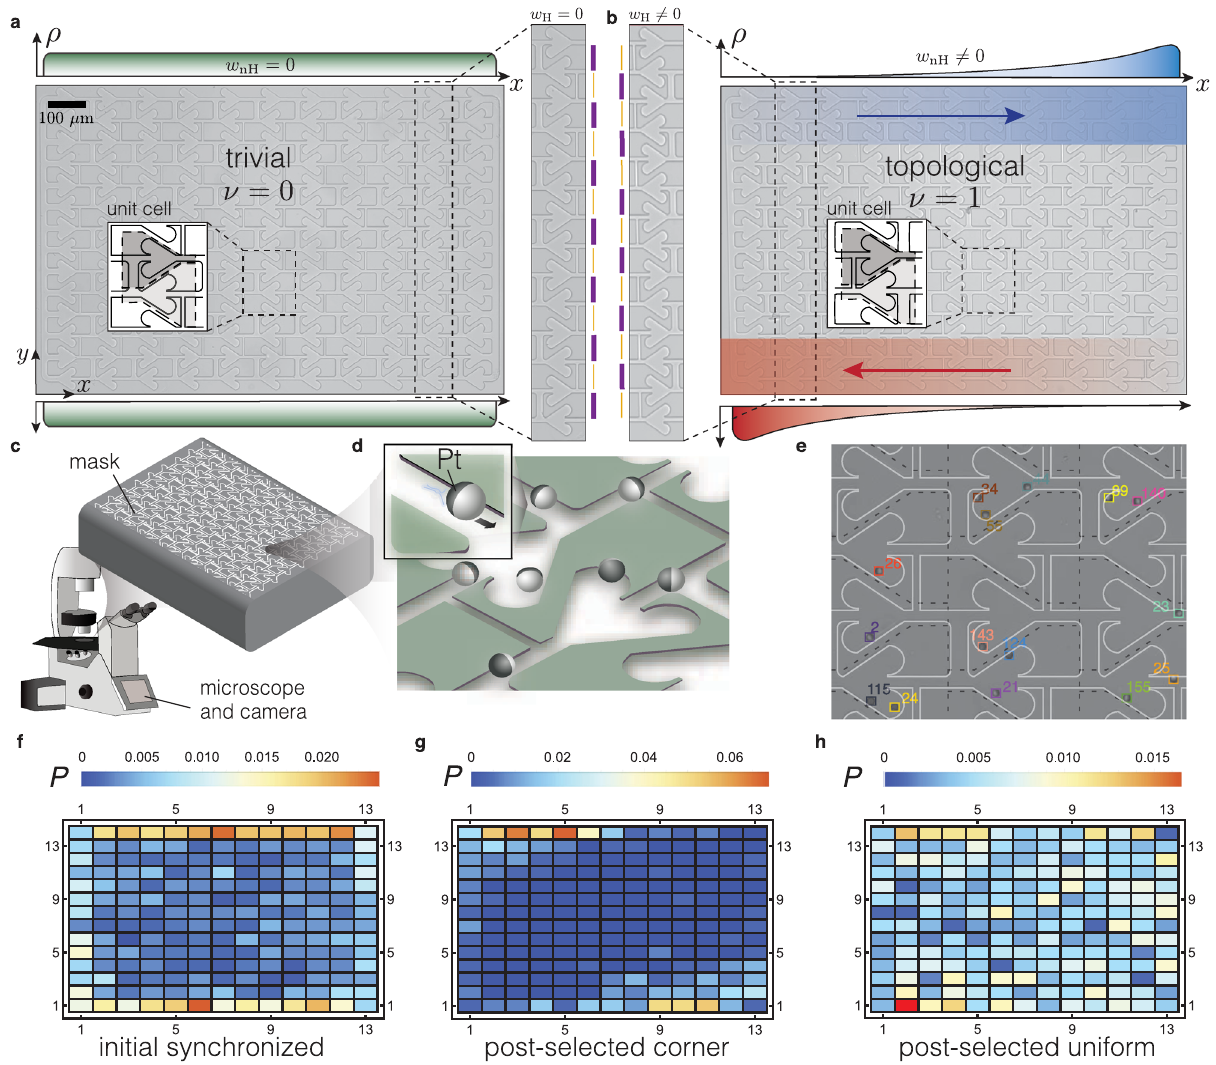
Fig. 1 Experimental designs. Panels ( a and b ) show the trivial and the topological devices, respectively, with ( L x , L y ) = (13, 14) unit cells. The insets depict the unit cells which are the same for both devices except the vertical wide and narrow channels are reversed, as shown in the zoomed central inset and emphasized with orange and purple lines. The topological device displays chiral edge modes at the top and bottom, sketched in blue and red, respectively, and which are related to a non-vanishing Hermitian topological invariant, w H . These topological edge modes have a non-vanishing non-Hermitian winding number, w nH , responsible for the accumulation of active particles at the corners. This accumulation at the corners is expected to vanish for the trivial device, see the uniform density in green, because the topological invariant ν = w H w nH vanishes. c , d A schematic of the experimental setup, where Pt- coated SiO 2 Janus particles self-propel when hydrogen peroxide is added, following the topographic features of each design. e A portion of the device to illustrate the tracking of particles by using a neural network, each particle is uniquely identi fi ed within our algorithm. We locate particles within the cells outlined by the dashed lines. f – h Probability distribution data, P , of particles on the lattice when trajectories are tracked and synchronized to start at the same initial time ( f ), post-selected to start at opposing corners ( g ), or post-selected to have an initial uniform distribution ( h ). The particle distributions in ( g and h ) are shown 3 min after synchronization. These initial particle distributions are similar for both topological and trivial